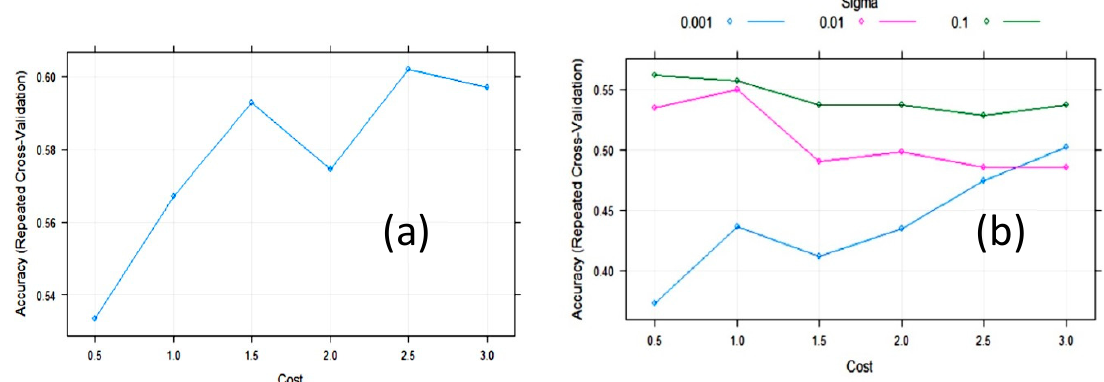
Figure 6. Change in accuracy of ( a ) Support vector machine with linear kernel (SVM L ) and ( b ) Support vector machine with radial kernel (SVM R ) during training with 10-fold cross-validation (CV) with the cost function.